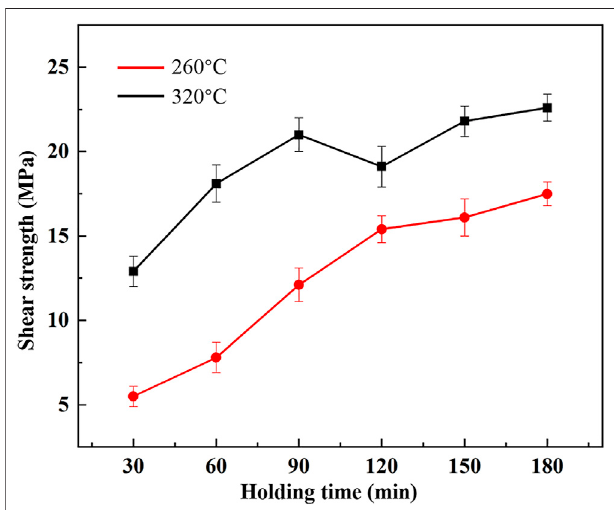
FIGURE 9 | Shear strength with different holding times at 260 and 320 ° C.